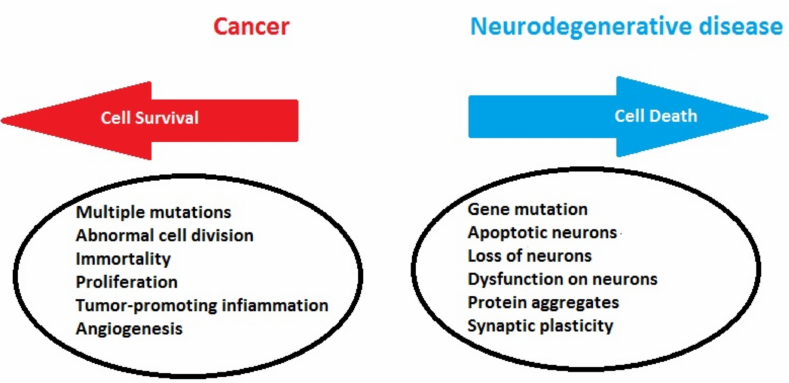
Figure 1. General biological mechanisms leading to neurodegenerative disease or